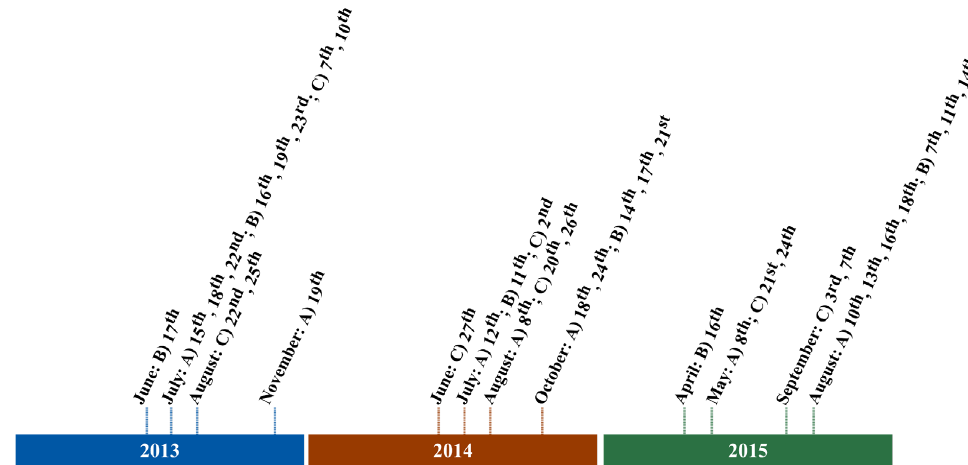
Figure 1. Timeline of processed AirMOSS dates per year and for every monitoring site. (A) Walnut Gulch, AZ, USA. (B) MOISST, OK, USA. (C) Harvard Forest, MA, USA.